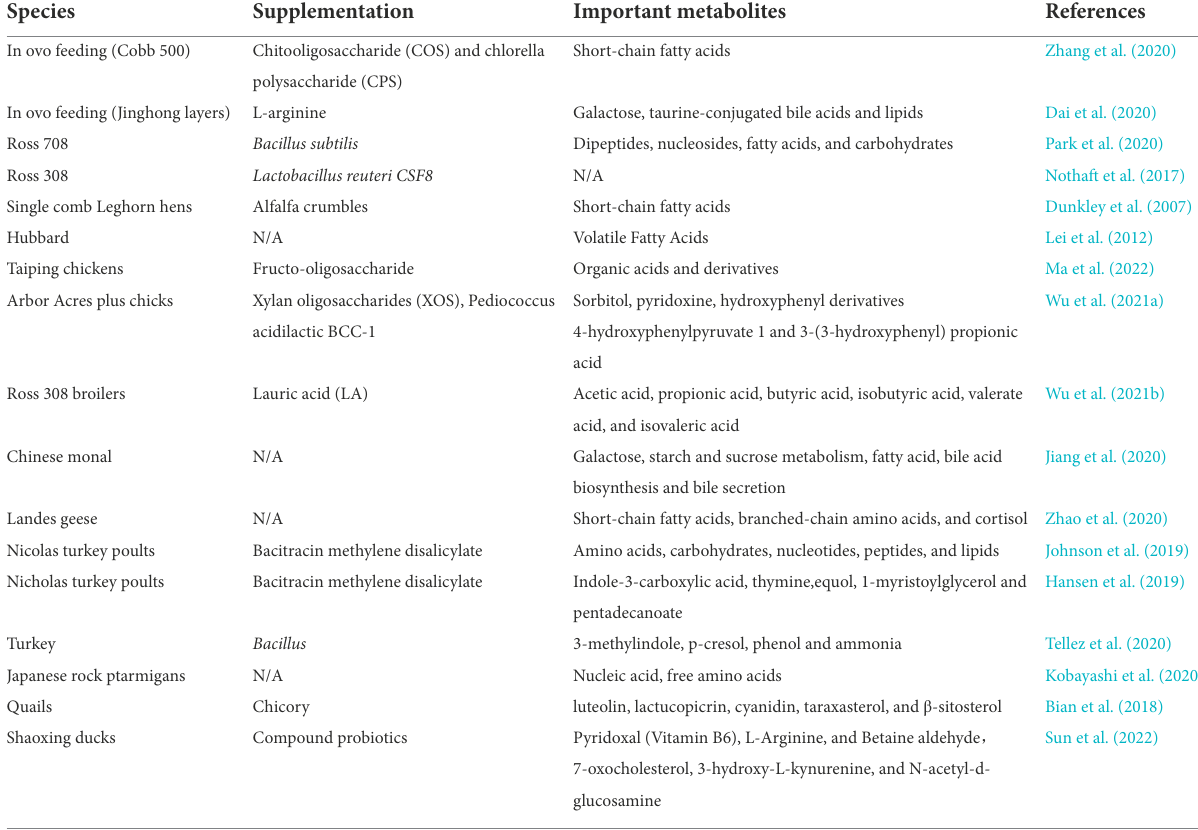
TABLE 6 Metabolomic study in poultry species, that were supplemented with prebiotics and probiotics at various developmental timepoints.